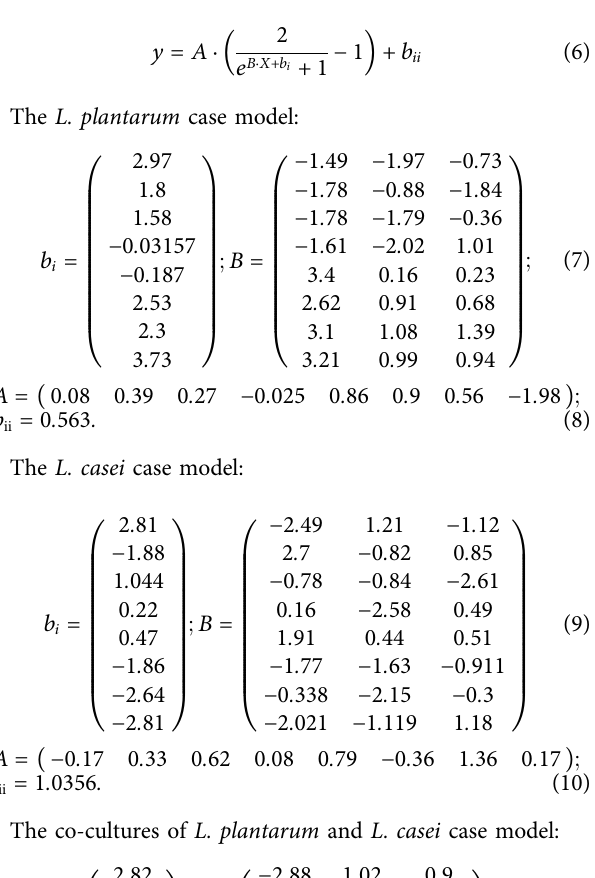
FIGURE10| 3DmodelsimulationresultswiththeLevenberg-Marquardt method and eight neurons for L. plantarum .